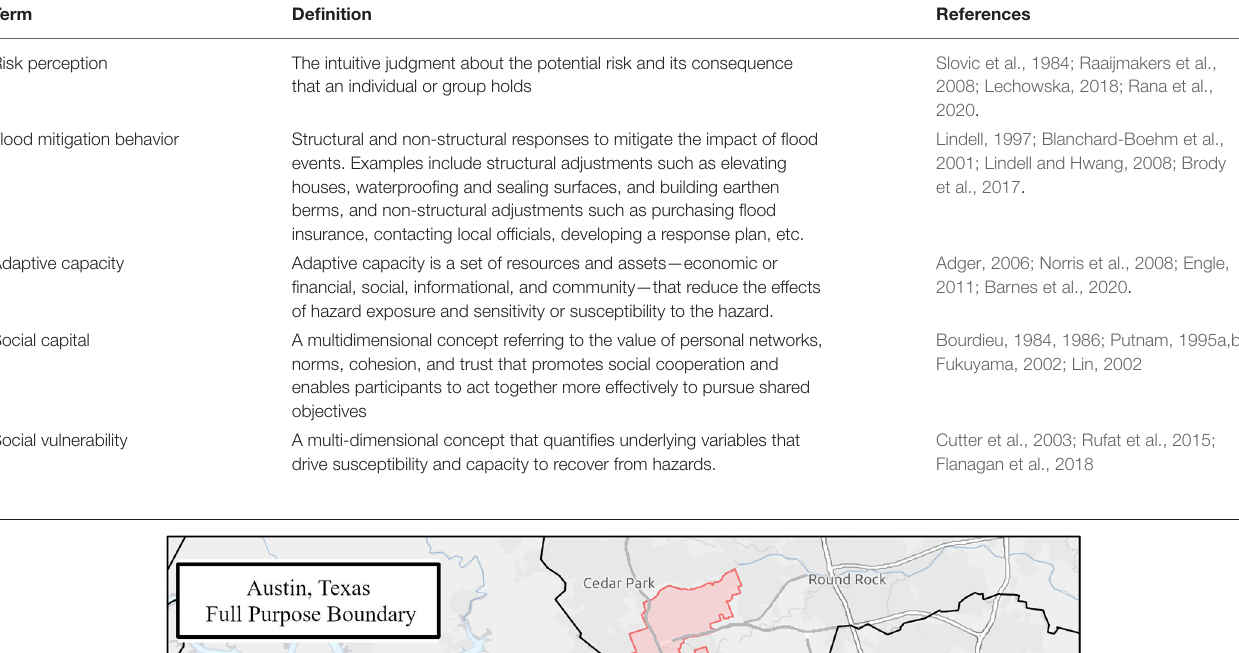
TABLE 1 | Terms and definitions.